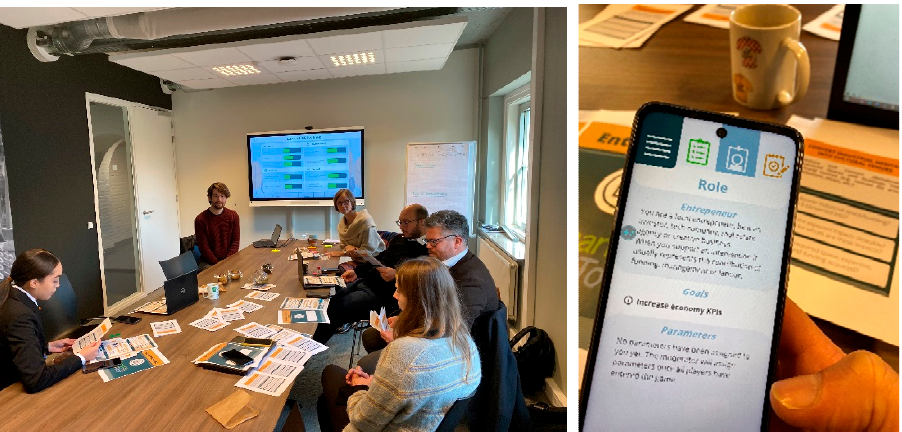
Figure 4. The SmartCulTour game ( right ) during a Living Lab session with stakeholders ( left ).